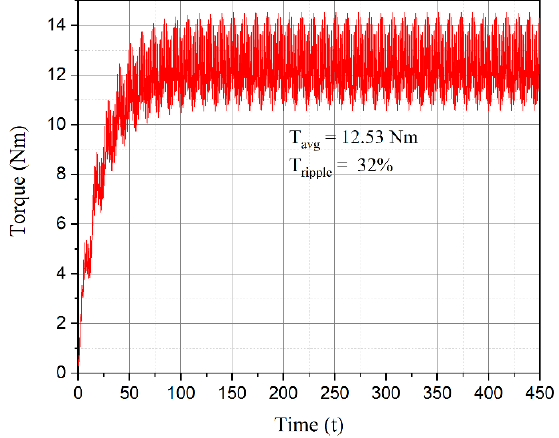
Figure 11. Torque generator of the SHSM. Table 2. Performance comparison between the conventional WRSM [14], BL-WRSM [15], and the proposed SHSM.